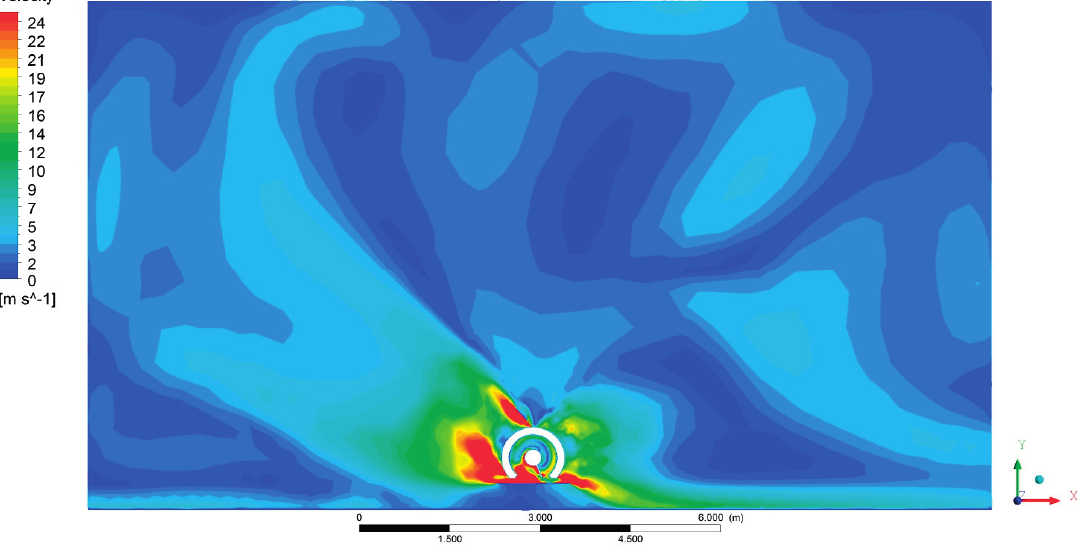
Figure 8. Air velocity obtained with CFD model in front section of sprayer (A). Both the front and rear fans are running. The fans are set to position 3.